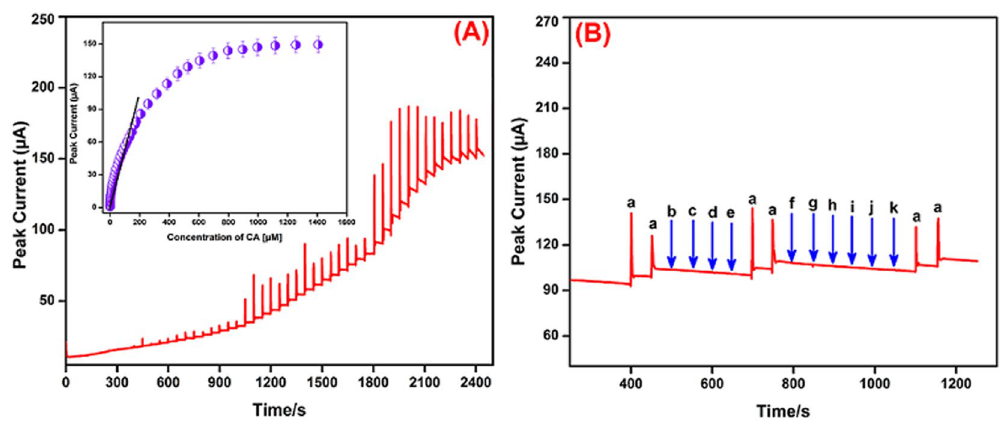
Figure 8. Amperometric ( i-t ) response at SrV 2 O 6 modified RDGCE upon successive additions of 0.01–1407 µ M CA into continuously stirred 0.1 M KCl. Applied potential + 0.58 V ( A ). At the same working conditions, amperometric response at SrV 2 O 6 modified RDGCE for 50 µ M of CA (a) 50 fold excess concentration of biologically co-interfering substances glucose (b), galactose (c), fructose (d), sucrose (e), catechol (f), ferulic acid (g), gallic acid (h), uric acid (i), ascorbic acid (j), dopamine (k) into continuously stirred 0.1 M KCl ( B